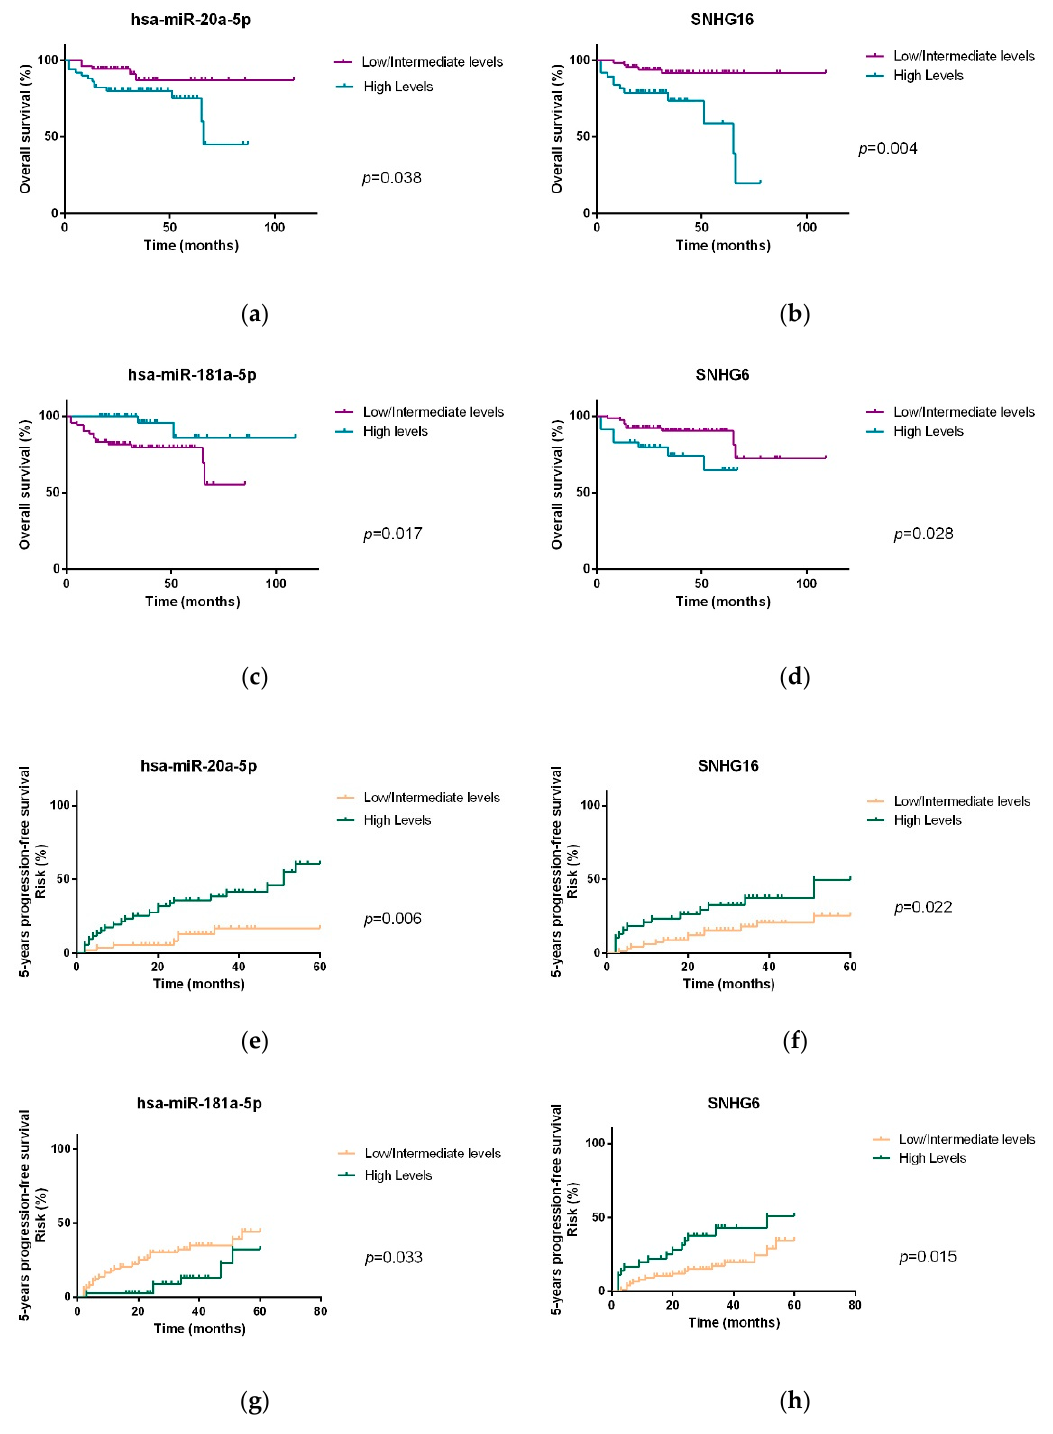
Figure 9. OS and PFS of NHL patients according to plasma levels of hsa-miR-20a-5p ( a , e ) hsa-miR- 181a-5p ( c , g ), SNHG16 ( b , f ) and SNHG6 ( d , h ). Table 4. The results of the univariate analysis for overall survival and 5-year progression-free sur- vival.